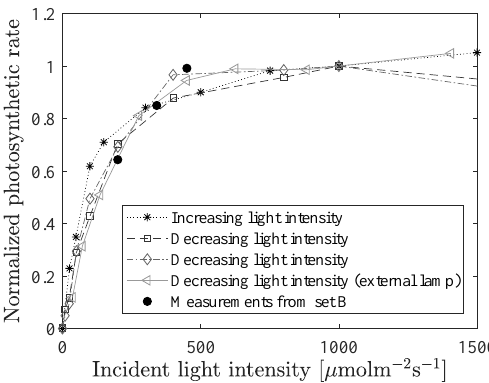
Figure 8. Normalized light curve for cucumber, i.e., the photosynthetic rate vs. light intensity. At low light the relation between incident light and photosynthetic rate is almost linear, but the dependency of the rate on the light intensity decreases, and for intensities higher than about 500 µmol m − 2 s − 1 , there is almost no increase in photosynthetic rate. This saturation